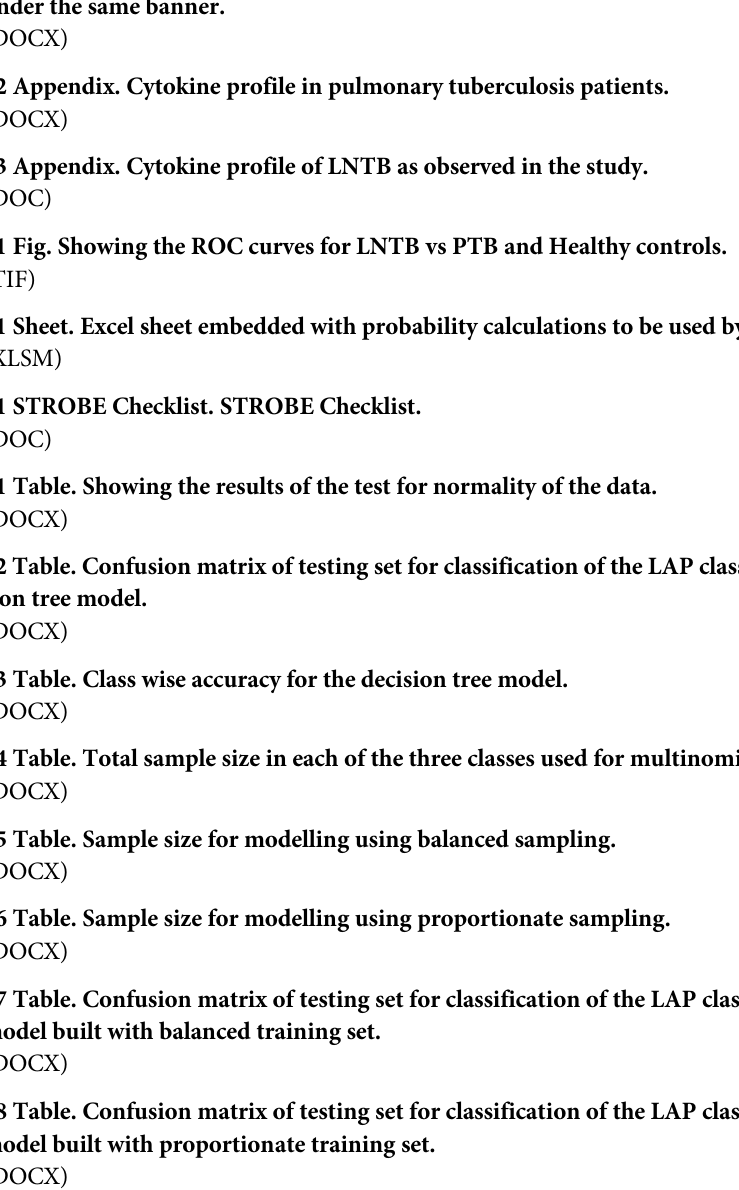
S8 Table. Confusion matrix of testing set for classification of the LAP classes using the model built with proportionate training